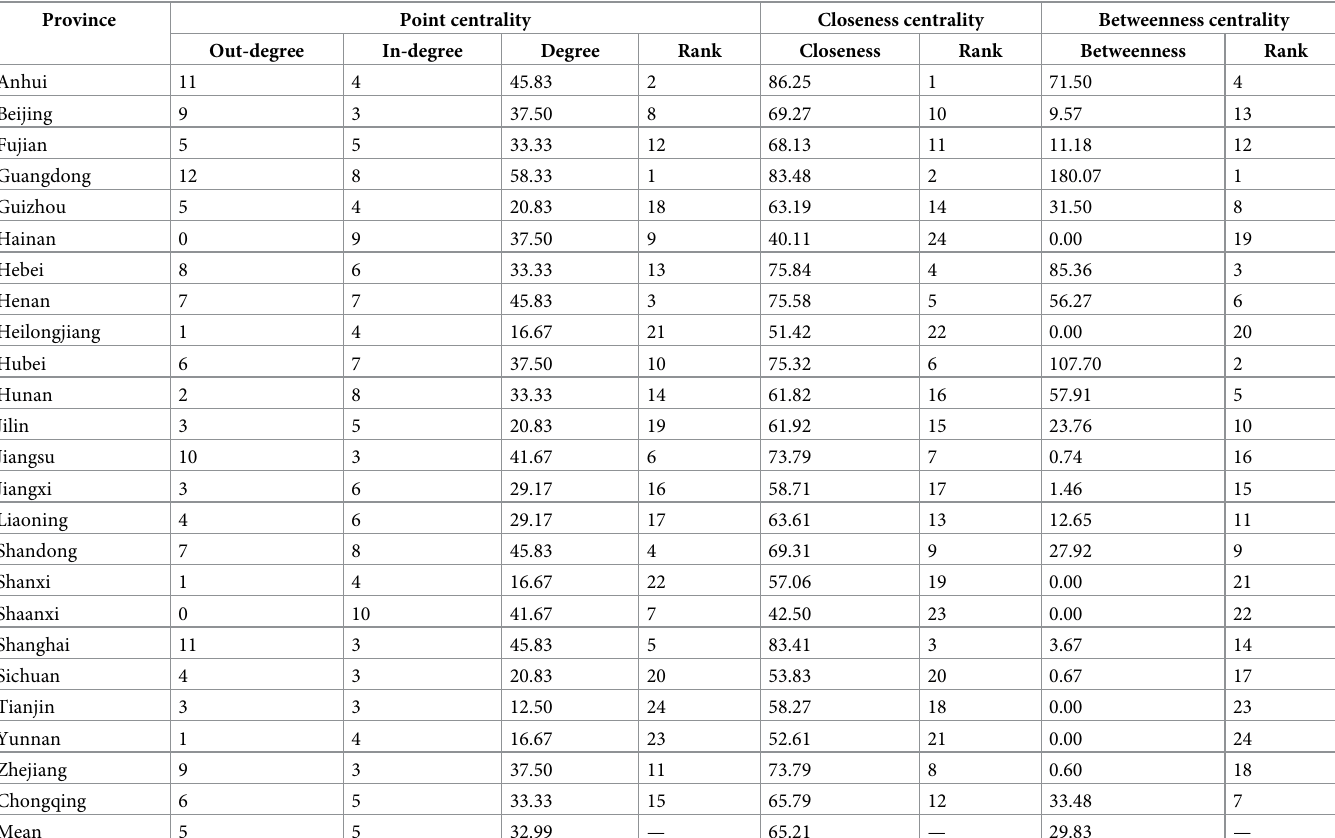
Table 1. Centrality analysis of innovation efficiency in the new energy vehicle spatial correlation network, for 2019.